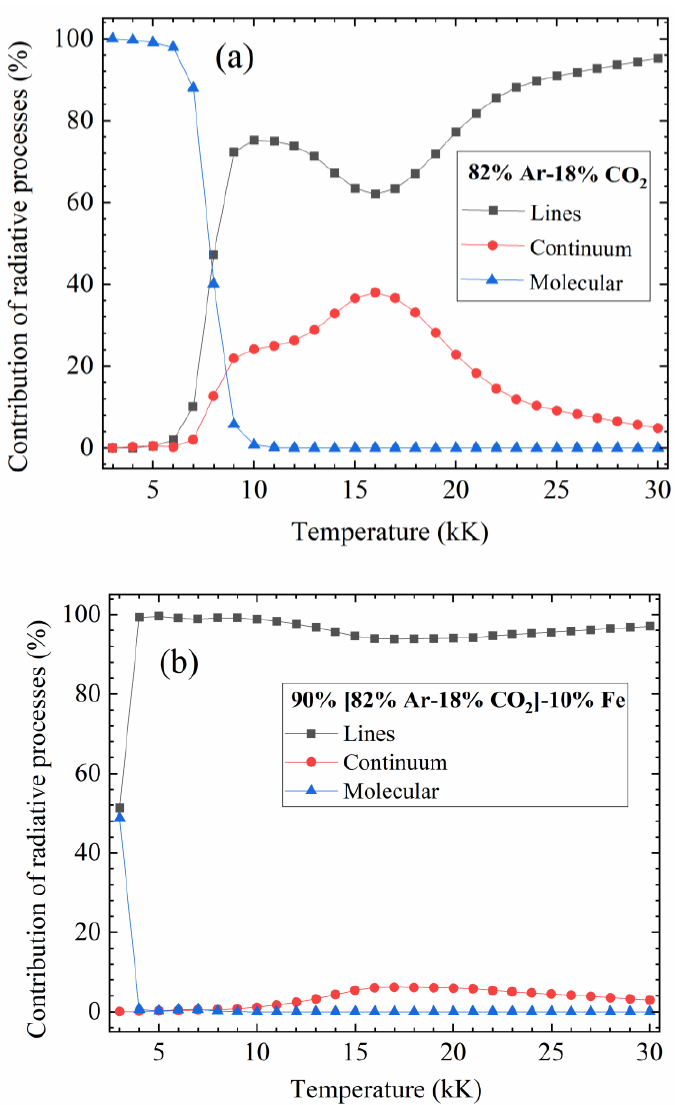
Figure 5. Contribution of the different radiative processes to the NEC for the plasmas at atmospheric pressure: ( a ) 82%Ar-18%CO 2 mixture; ( b ) 90%[82%Ar-18%CO 2 ]-10%Fe (molar proportions). pressure: ( a ) 82%Ar-18%CO 2 mixture; ( b ) 90%[82%Ar-18%CO 2 ]-10%Fe (molar